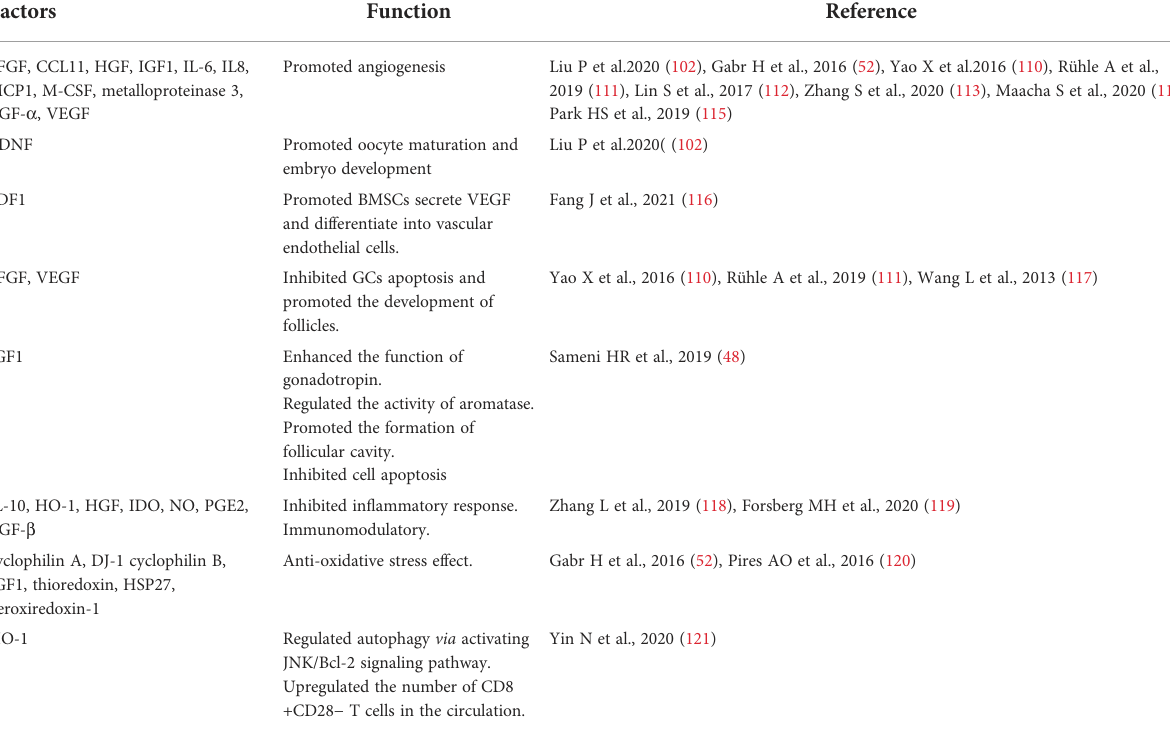
bFGF,basic fi broblastgrowthfactor;CCL11,C-Cmotifchemokineligand11;GCs,granulosacells;HO-1,hemeoxygenase1;HGF,hepatocytegrowthfactor;HSP,heatshockprotein;IDO, indoleamine 2,3 dioxygenase; MCP1, monocyte chemoattractant protein1; M-CSF, macrophage colony-stimulating factor; NO, nitric oxide; PGE2, prostaglandin E2; SDF1, stromal cell- derived factor-1; TGF- b , transforming growth factor-beta; TGF- a , transforming growth factor- a